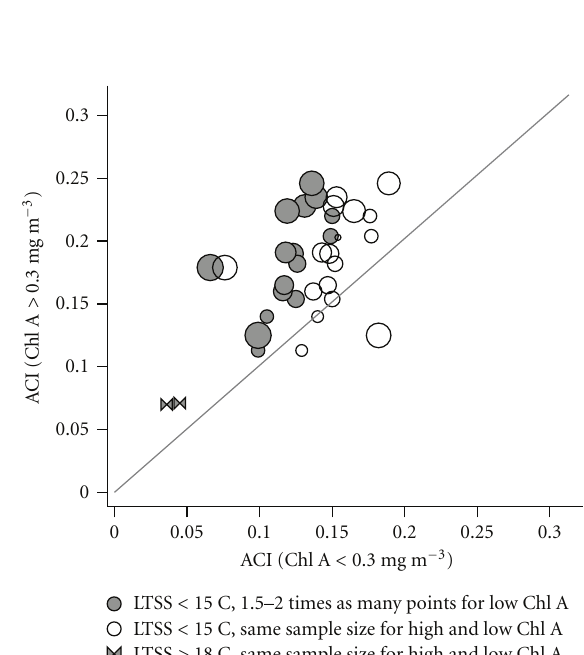
Figure 3: Comparison of ACI r values (1) for periods of relatively high and low chlorophyll A concentration in the Southern Ocean region based on data over a span of 27 months starting in June 2006. Marker sizes are proportional to LWP between 50 and 350 gm − 2 (11 total LWP